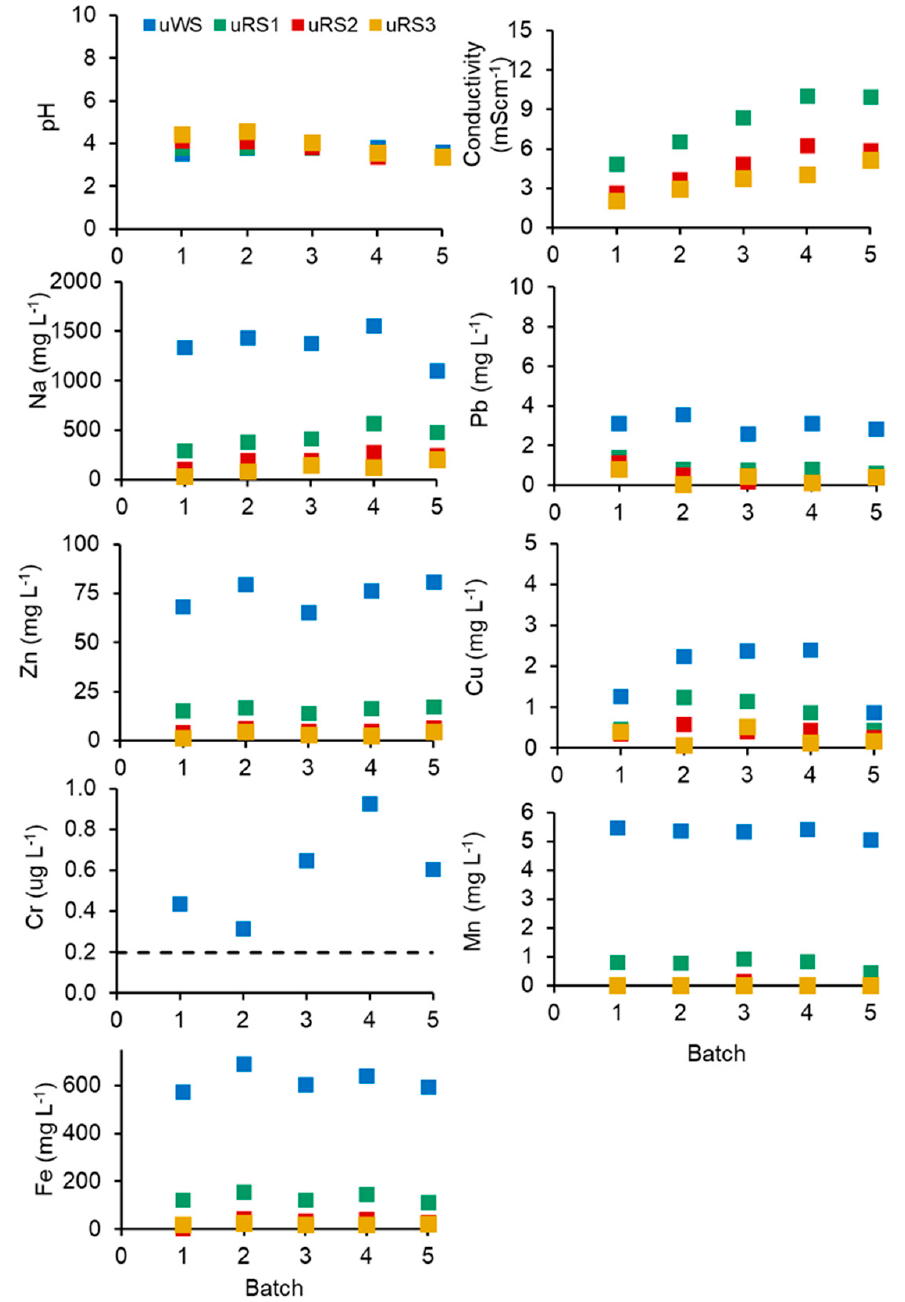
Figure 2. The properties of used washing, first, second, and third rinsing solutions (uWS, uRS1, uRS2, and uRS3, respectively) over the five successive washing batches.